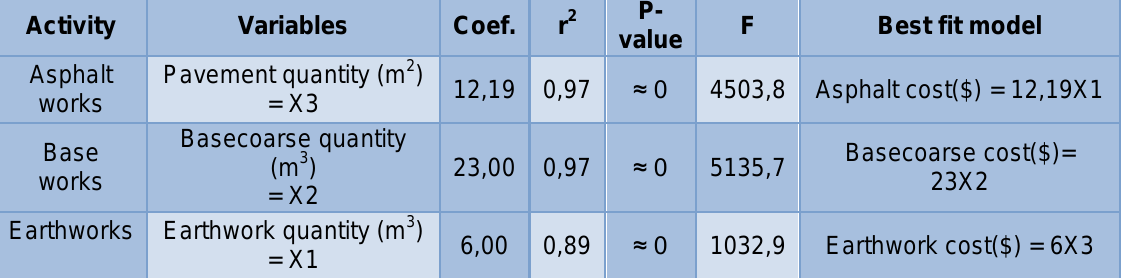
Table 9 Regression models among cost of each major activity in road construction and its quantity